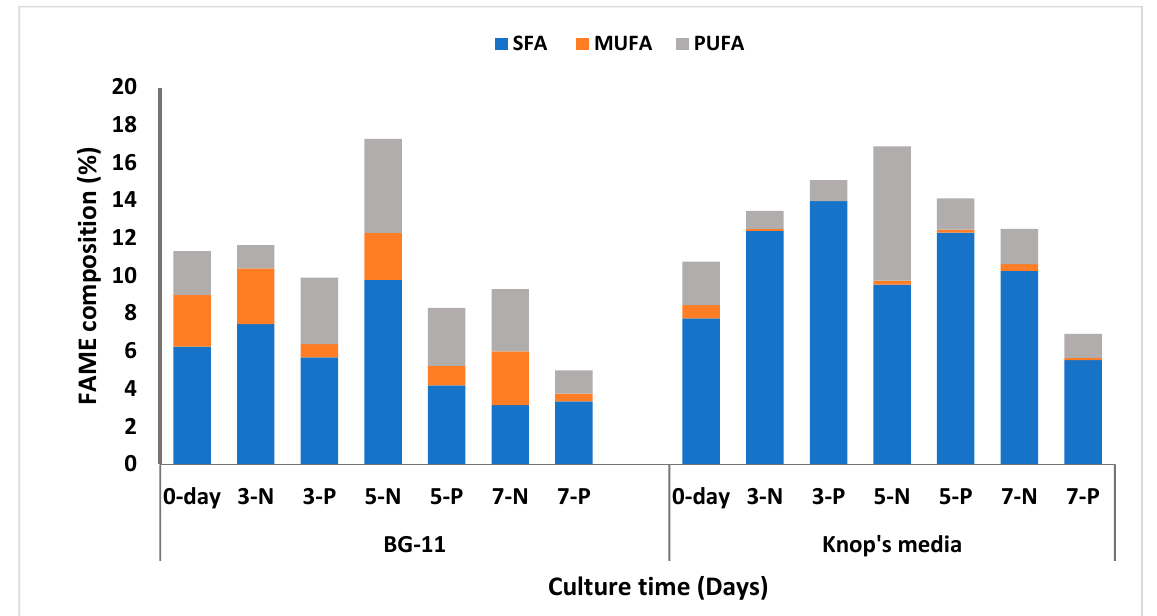
Figure 3. FAME composition of Chlorella sorokiniana isolated from BG-11 and Knop’s media (at pH-9) cultured in nutrient amended media.